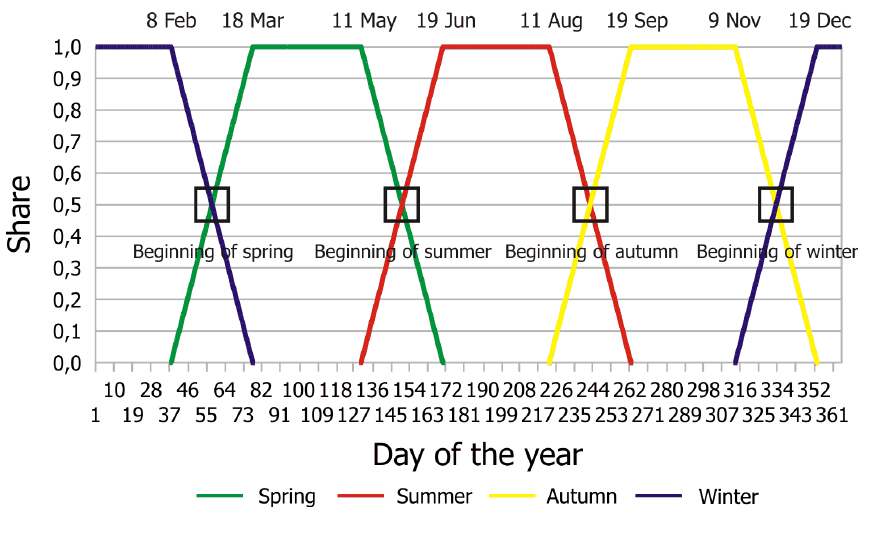
Figure 8. Sketch of the priority of the season-specific class assignments over the